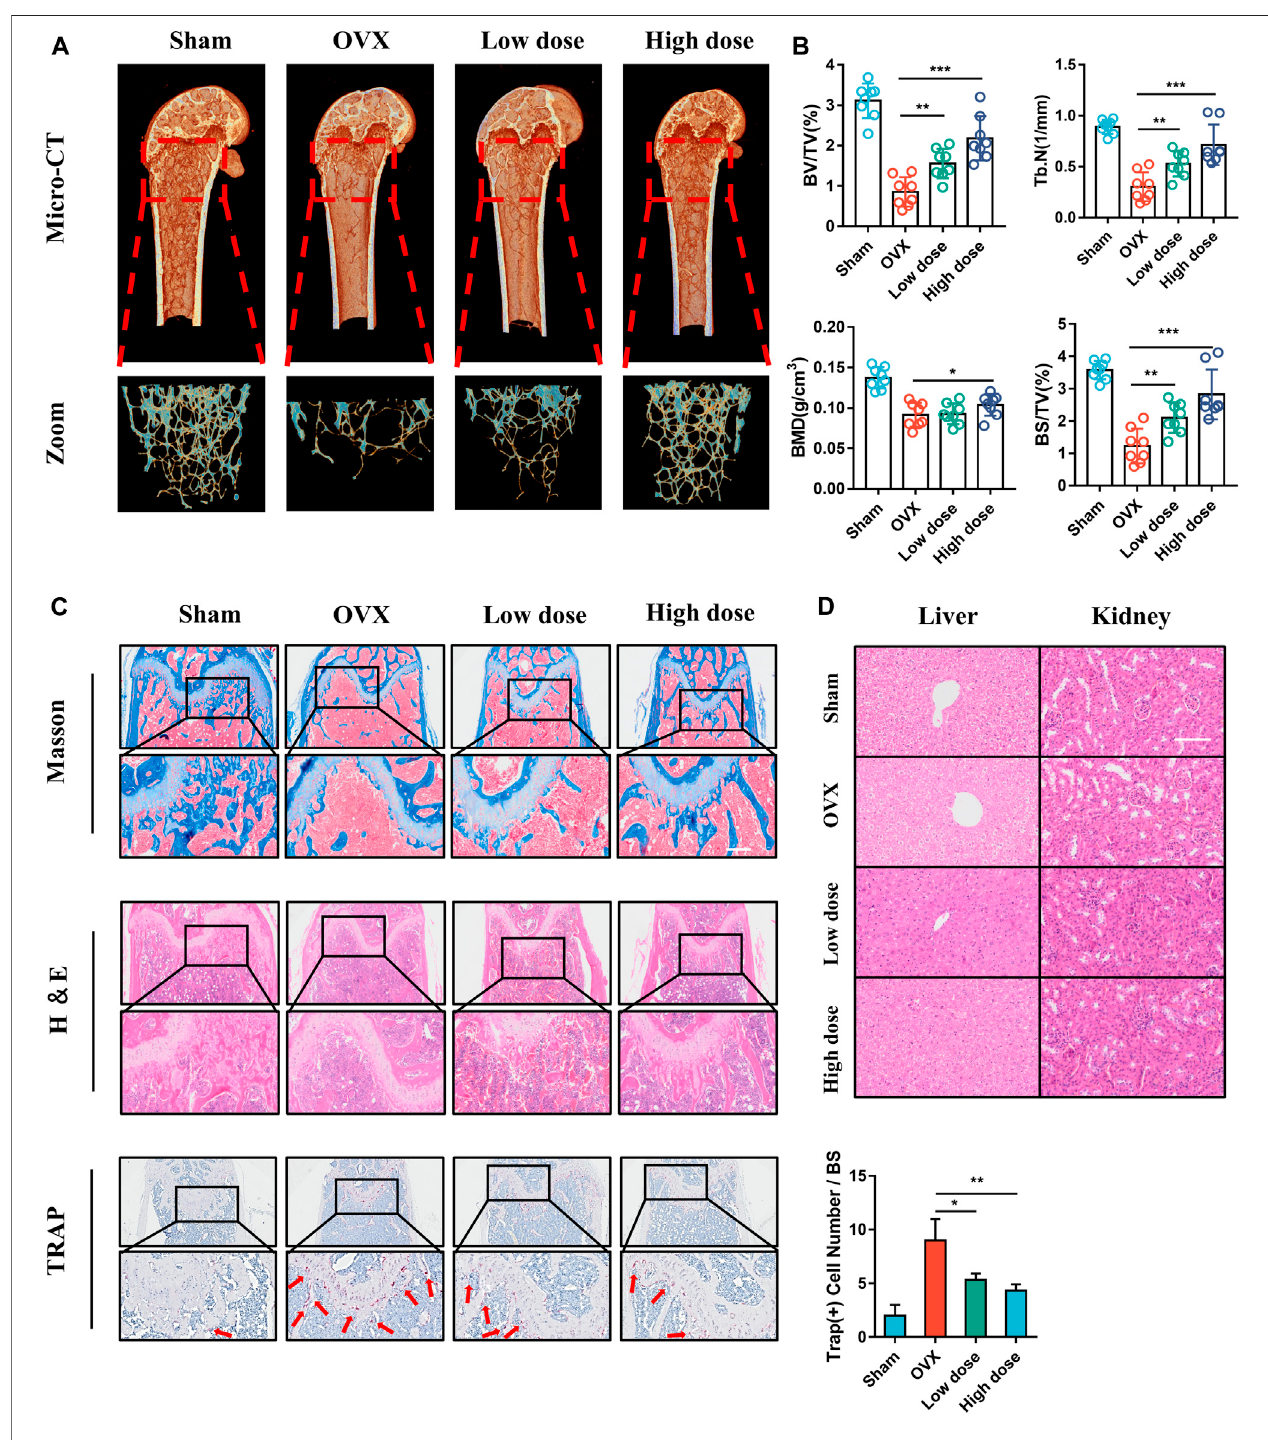
FIGURE 8 | BCI protects against OVX-induced osteoporosis in mice. (A) Micro-CT images and 3D reconstruction of femurs from mice in the Sham, OVX, OVX + low-dose BCI, and OVX + high-dose BCI groups. (B) Statistical analysis of the bone parameters BV/TV, Tb.N, BMD, and BS/TV. (C) Representative images of histomorphologic analysis, including H&E, Masson, and TRAP staining. (D) H&E staining showing pathological changes in the liver and kidney of mice from each group.